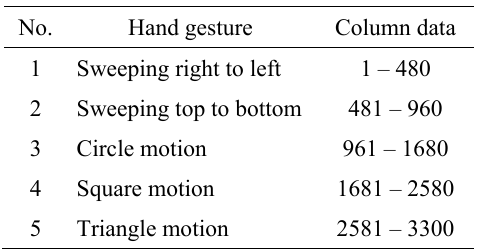
Table 1. The cluster of column data matching to